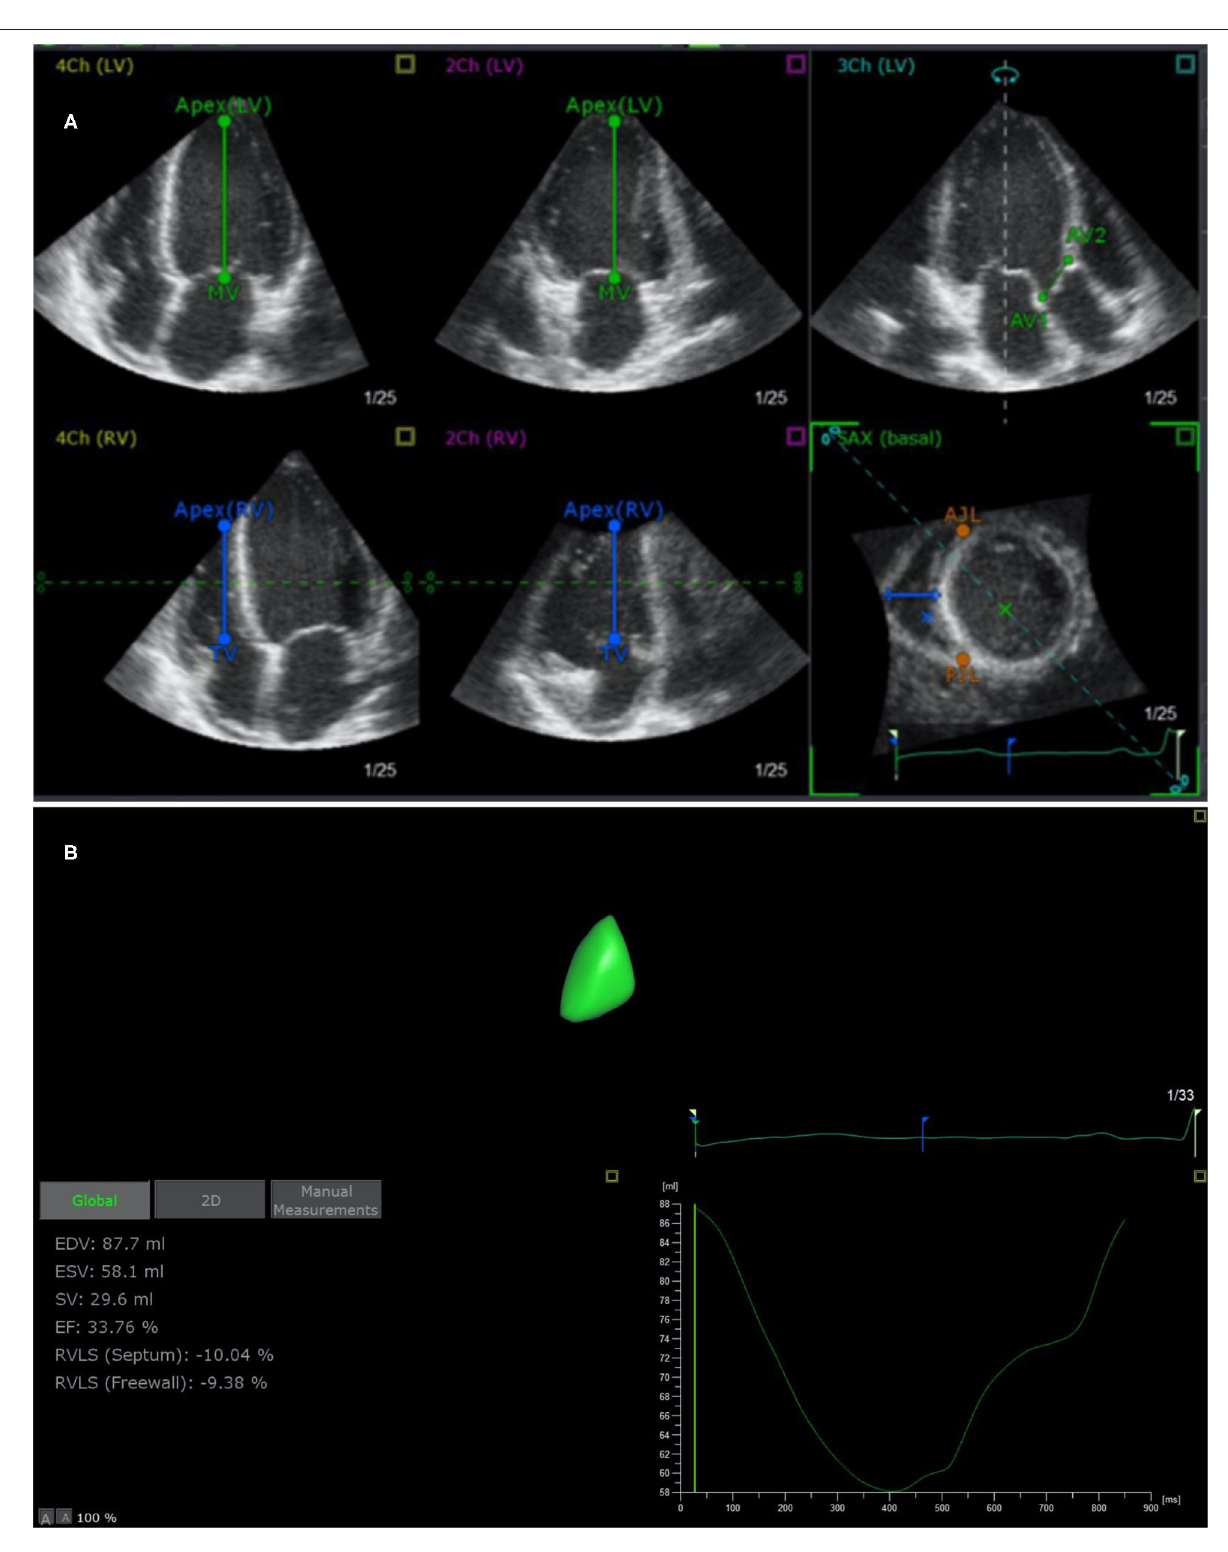
Frontiers in Cardiovascular Medicine |